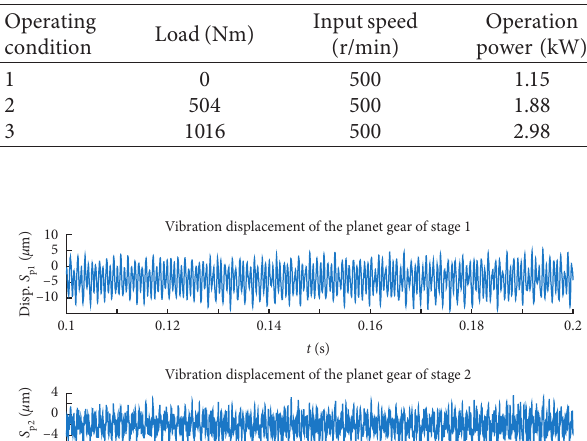
Table 2: Operation parameters.